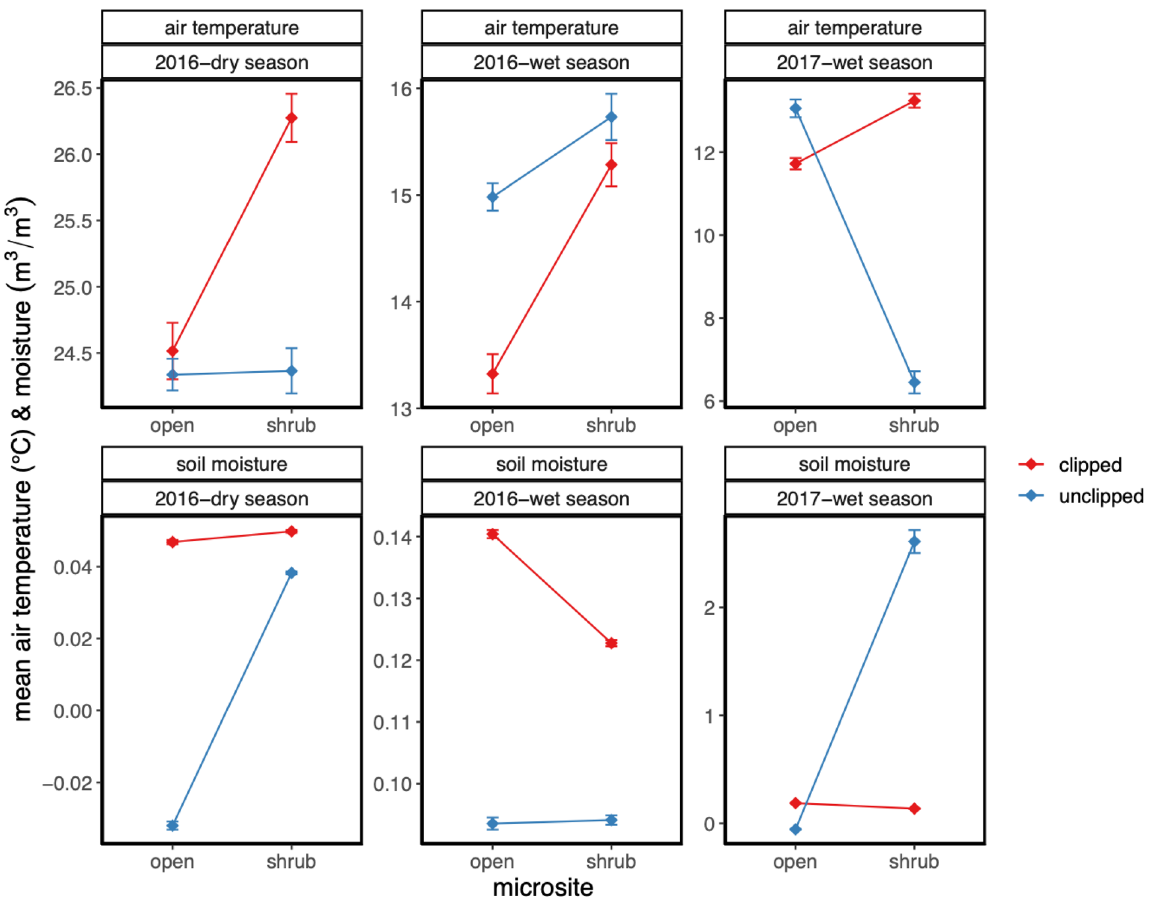
Figure 2. A contrast of the mean near-surface air temperatures and soil moisture content in Cuyama Valley, California in 2016 and the winter of 2017. Shrubs microsites are under the canopy of the resident native species Ephedra californica , and open are microsites without a woody canopy of a shrub. Clipped refers to the treatment of removing all aboveground non-woody vegetation both under shrubs and in the open. This sampling estimated microclimate at the peak of the SWNA megadrought. These plots depict seasonal means for each factor level (see Methods for delineations). Data models, statistical analyses, and visualization for this figure were done in R version 4.2.1 (see Supplement for full script and